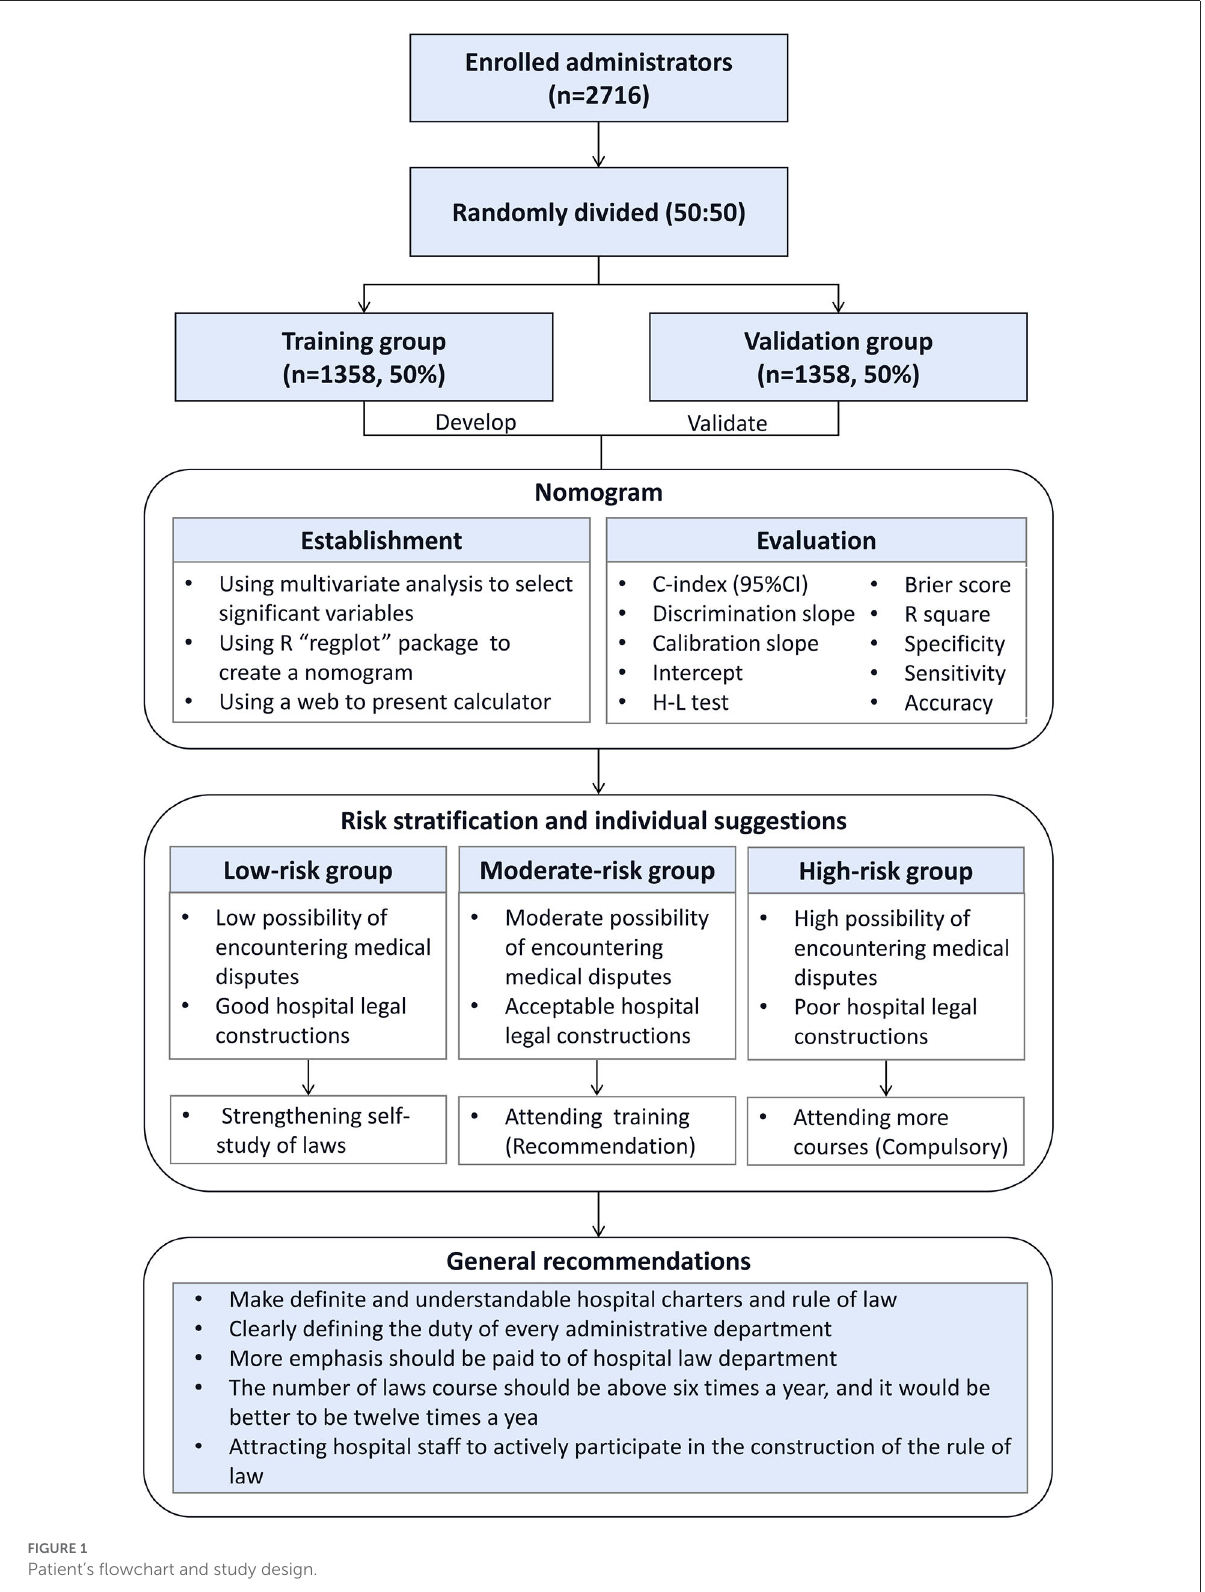
FIGURE1 Patient’s flowchart and study